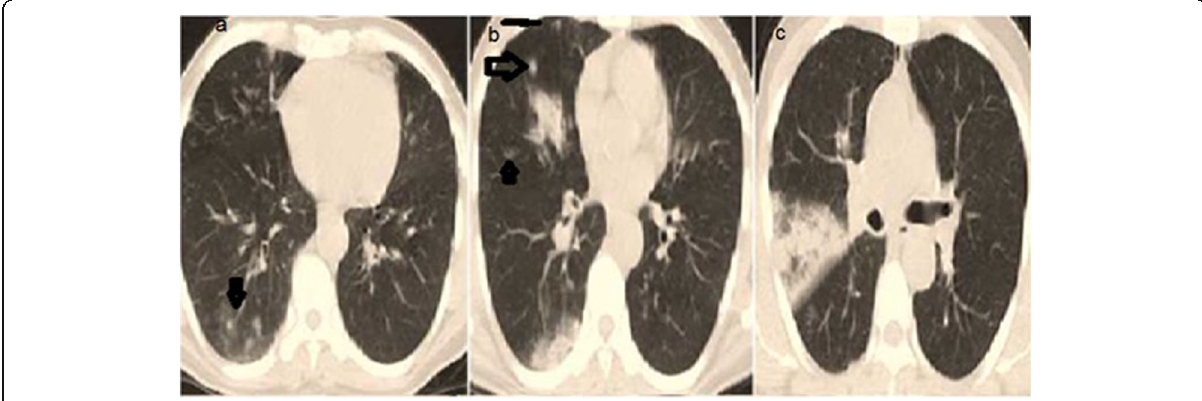
Fig. 2 “ A 44-year-old female patient with a history of breast cancer. ” | MCCT exam axial views revealed multiple well-defined small solid nodules scattered at the periphery of the Rt. upper and lower lung lobes ( a , b ) that categorized as lung-RADS score 4X, “ malignant metastatic solid nodular lesions ” that is on follow-up after 1 month ( c ) proved to be benign inflammatory granuloma according to final clinical